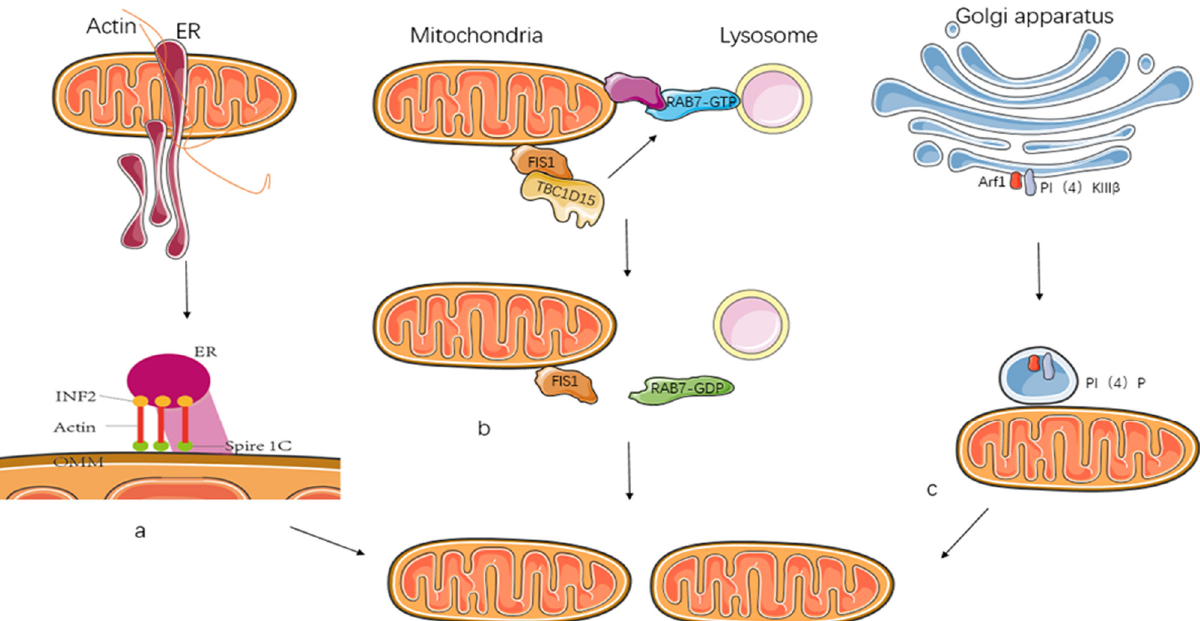
5 of 20 Figure 3. Cristae remodeling. (a): Under normal conditions, L-OPA1 and S-OPA1 are able to form oligomers to maintain the structure and function of the cristae. (b): The cristae remodel, the opening of the cristae becomes larger, and the contents of the cristae are released. 2.4. Mitochondrial Dynamics with Other Cellular Organelles